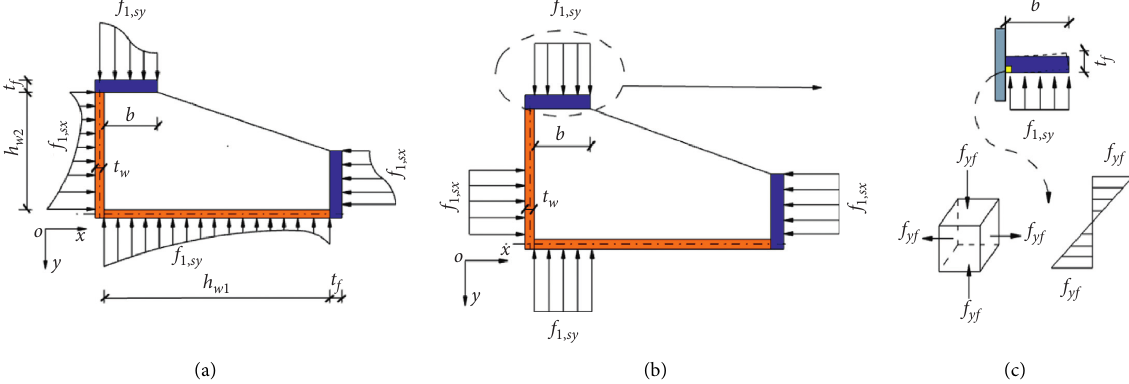
Figure 11: Distribution of the lateral confining stress: (a) actual confining stress, (b) simplified confining stress, and (c) flange stress